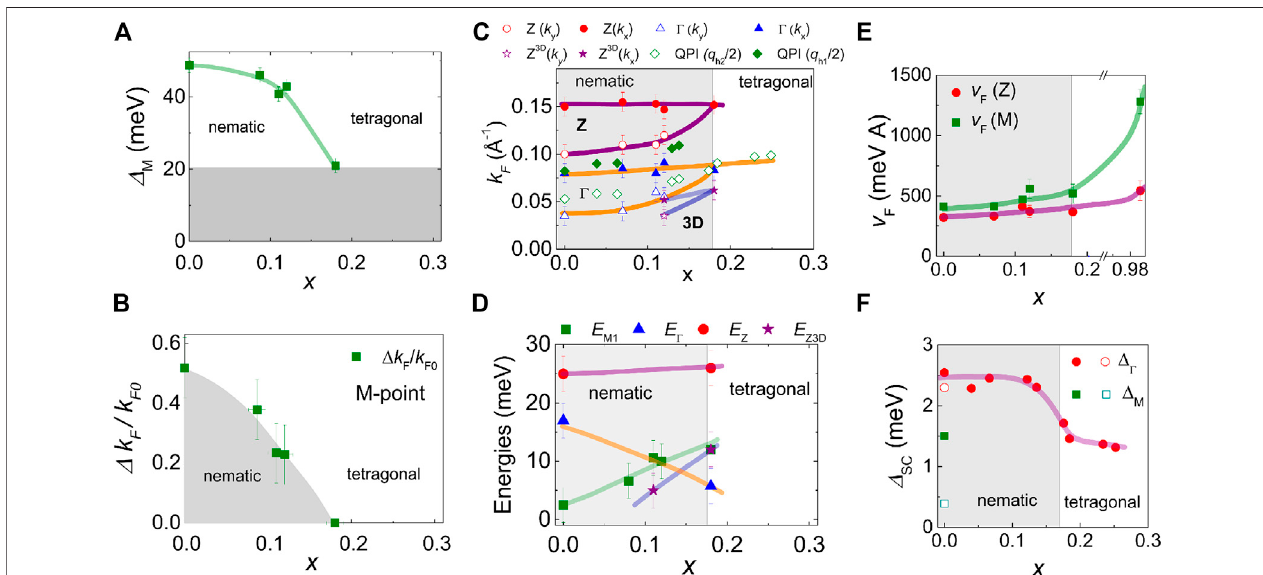
FIGURE 4 | Low temperature parameters extracted from APRES data of FeSe 1 − x S x . (A) The variation of the low temperature splitting parameter, Δ M , extracted fromEDCsattheMpoint,with x substitution,shownin Figure1G .Asplittingof20 meVisalreadypresentforthetetragonal x (cid:2) 0.18suggestingtheeffectofnematicityis less than Δ M for x (cid:2) 0 [29, 40]. (B) The relative distortion of the electron Fermi surface at the M point, Δ k F / k F 0 , at T ∼ 13 K in relation with the tetragonal phase k F 0 , as a functionof x substitution (afterRef.40). (C) The variation oftheFermi k F vector with x forthehole pockets extracted from the MDCcuts and assuming thatthe data arisesfromtwosuperimposedellipses.Thevalueofthe q /2scatteringvectorsfromQPIarecomparedwiththosefromARPESdata,afterRef.46. (D) Thevariationofthe energy of the top or bottom of the bands at different high-symmetry points. (E) The Fermi velocities extracted form the slope of the energy dispersion as a function of momentumfortheholeandtheelectronbands,afterRefs.29,40. (F) The x variationofthesuperconductinggap, | Δ SC | ,extractedfortheholebandforFeSe 1 − x S x andthe electron band for FeSe, after Refs. 46, 78. Another potential small gap of 0.39 meV (open square) was invoked from speci fi c heat data for FeSe